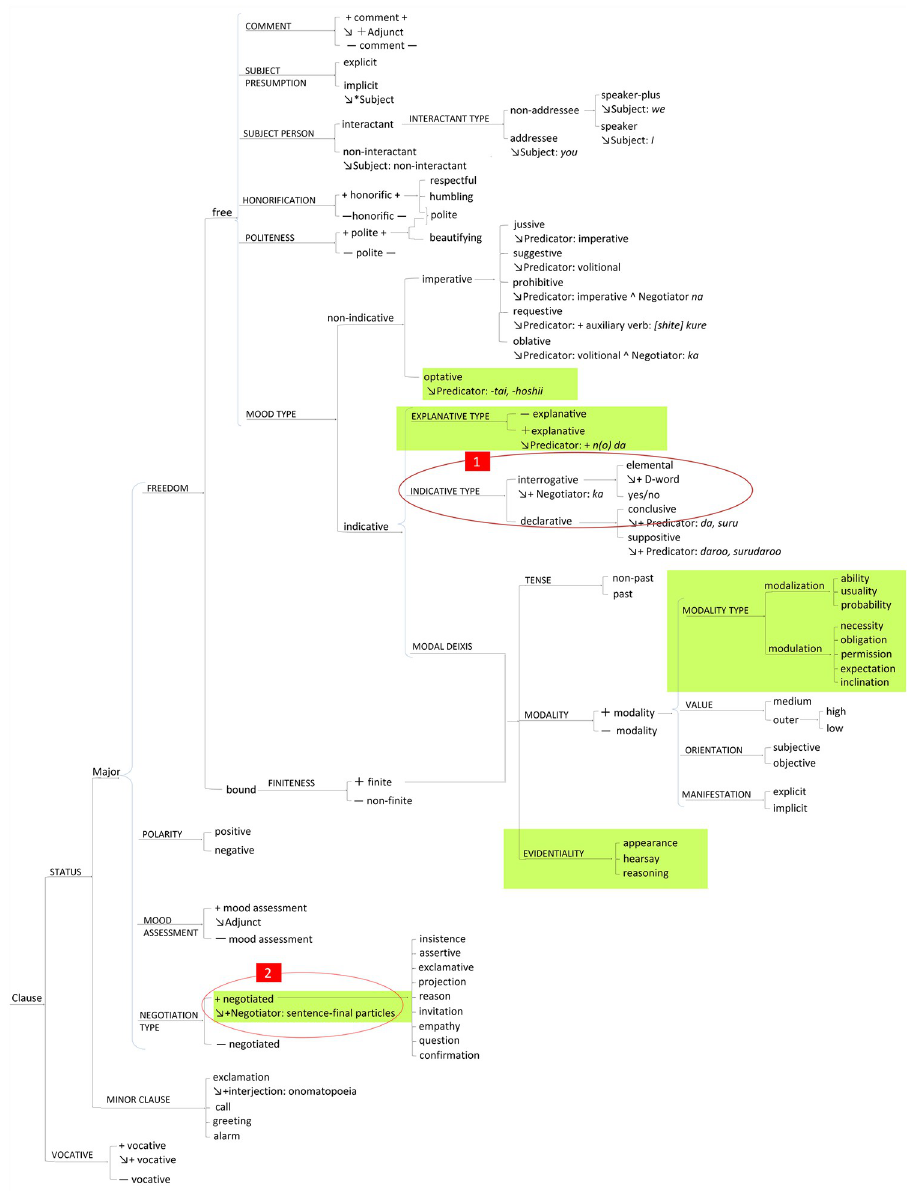
Fig 7. The system network of MOOD (mood selection) in Japanese from the interpersonal metafunction. This was modified from Teruya [50] and Kadooka, Kato, Iimura et al. [51]. The red-circled Part 1 is in Fig 4, and the red-circled Part 2 is discussed as Identifying PI in negotiating particles in Results. The speakers are expected to choose one from a set of oppositions, with the degree of delicacy increasing from left to right on the network. The current annotation scheme incorporated the items in the green-colored